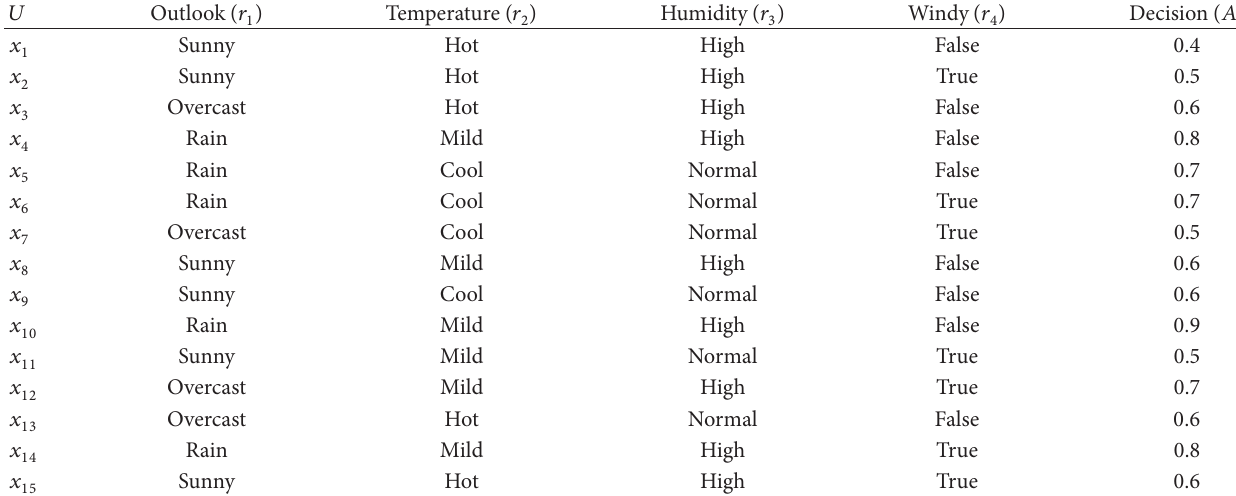
Table 2: Fuzzy-target decision-making